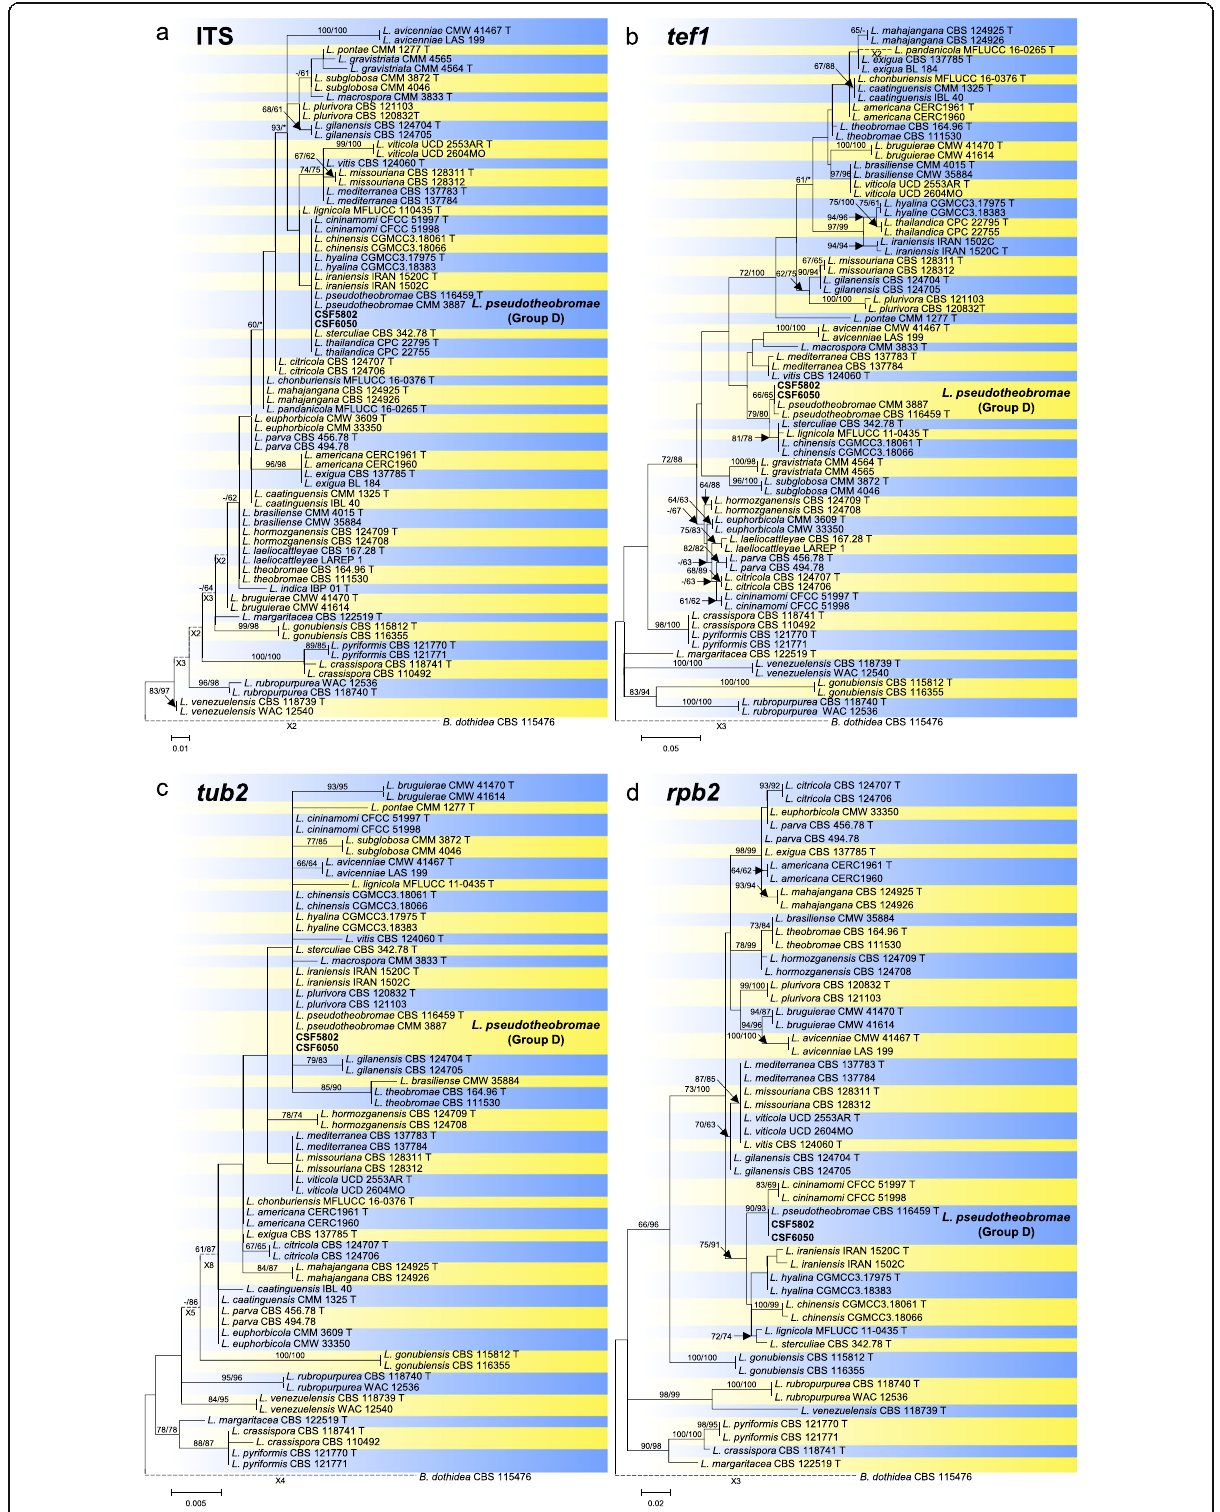
Fig. 3 Phylogenetic trees based on maximum likelihood (ML) analyses for species in Lasiodiplodia . a . ITS; b . tef1 ; c . tub2 ; d . rpb2 ; e . combination of ITS, tef1 , tub2 and rpb2 . Isolates sequenced in this study are in bold. Bootstrap support values ≥ 60% for ML and MP are presented above branches as follows: ML/MP, bootstrap values <60% are marked with ‘ - ’ , and absent are marked with ‘ * ’ Ex-type isolates are marked with ‘ T ’ . The trees were rooted to B. dothidea (CBS